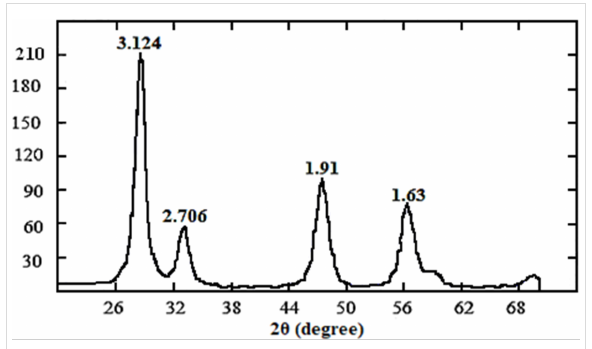
Figure 7: X-ray diffraction pattern for a CeO 2 (JCPDS Card No. 43-1002) nanopowder obtained from a cryosol (XRD-6000 Shimadzu,